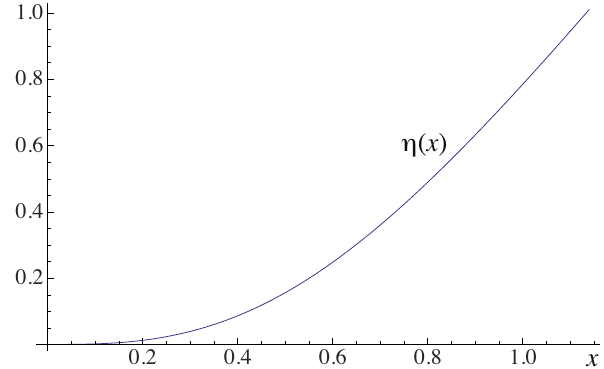
Figure 11. The fractional error η ( x ) in the single-term Casimir for- mula, defined by Eq. (72), inferred from the numerically evaluated integral